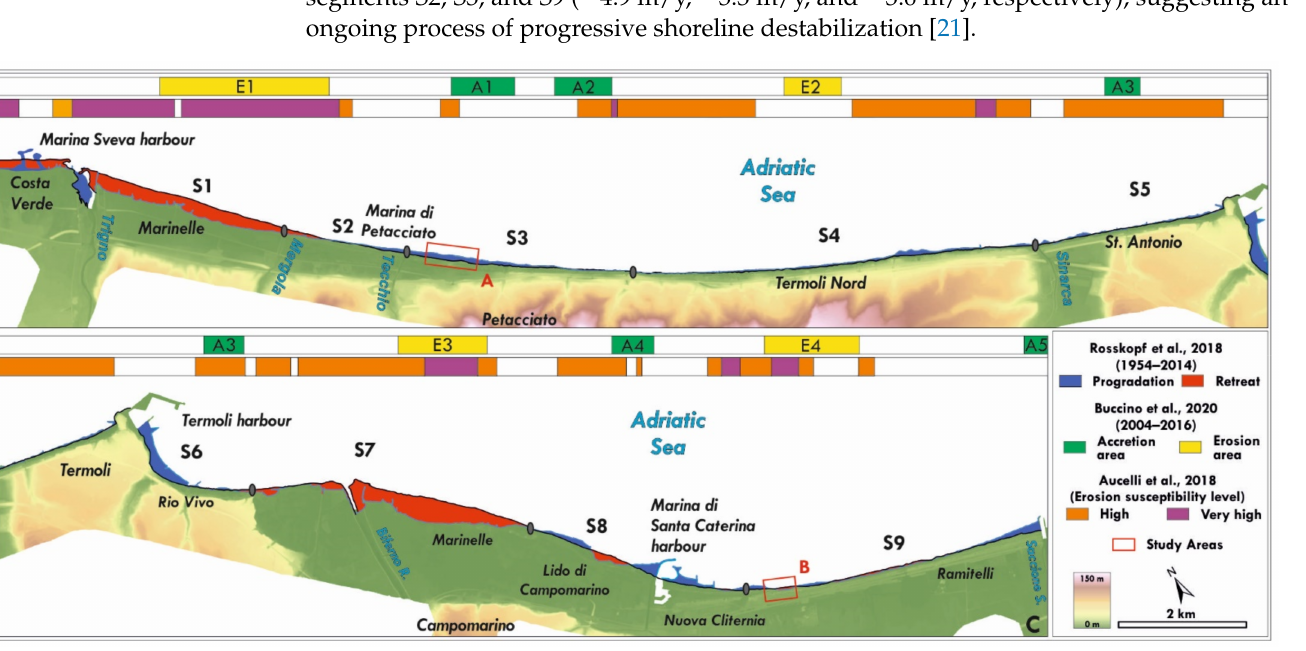
Figure 2. Shoreline progradation and retreat rates from 1954 to 2014 [21], location of areas with high to very high levels of erosion susceptibility [22], and location of mid-term (2004–2016) major shoreline erosion/accretion areas E1–E4 and A1–A5